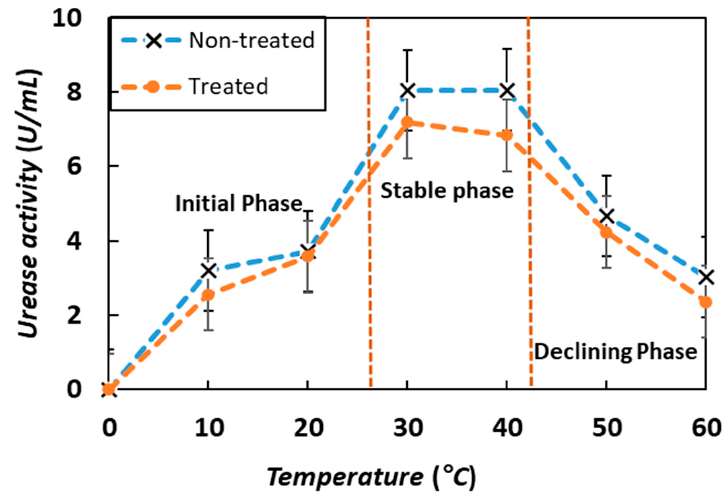
Figure 5. Urease activity varying with temperature.